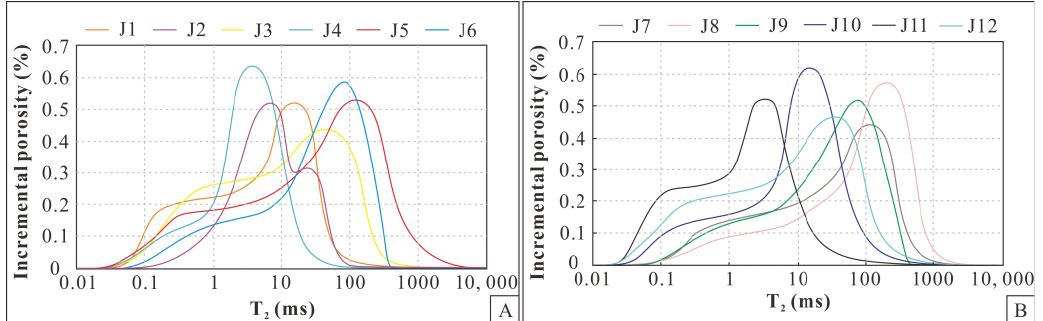
Figure 10. NMR T 2 spectrum distribution under fully saturated water conditions. ( A ) T 2 spectral distributions and corresponding porosity increments for samples J1 to J6. ( B ) T 2 spectral distributions and corresponding porosity increments for samples J7 to J12.